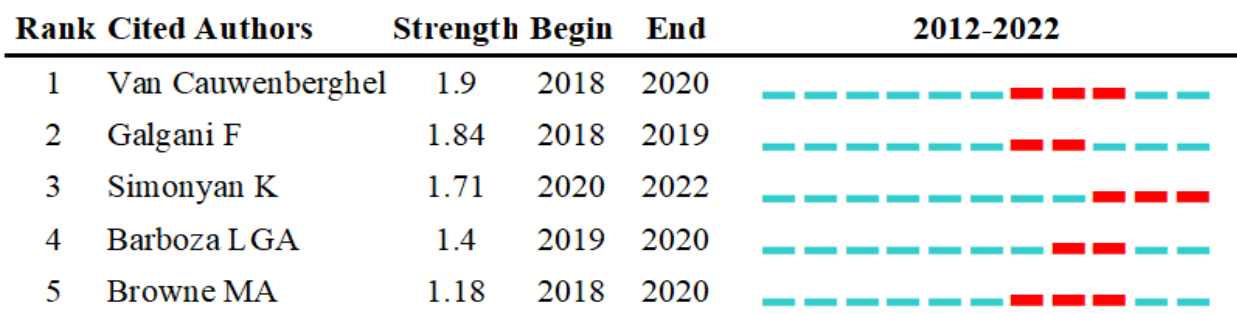
Figure 18. The most co-cited authors with citation bursts (Visualized with CiteSpace. The red bar: the year of the citation burst, and the light blue color: no citation burst.).